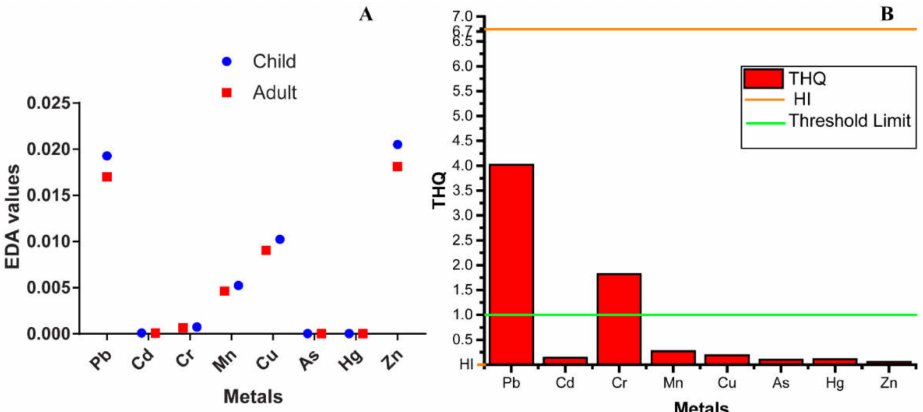
Figure 3. Public-health-related hazard indices (( A )-EDA, ( B )-THQ & HI) for metal concentrations in